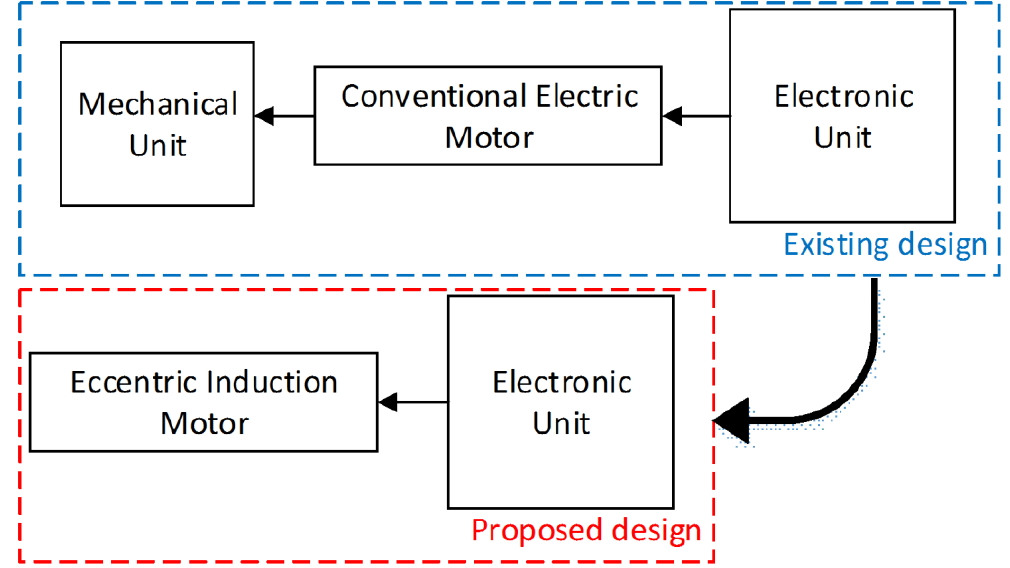
Figure 1. Block diagram of the transmission oil pump driving system.